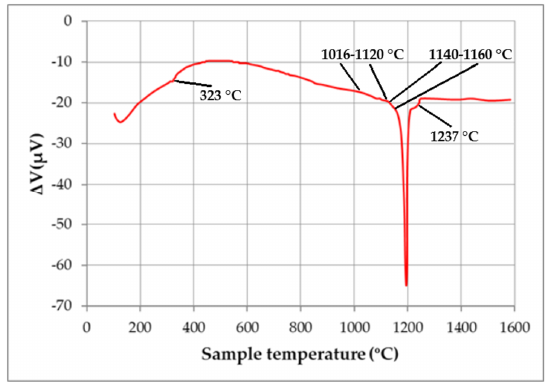
Figure 5. DTA curve measured during heating of the magnet prepared by recycling.